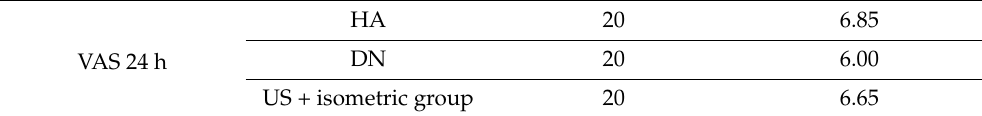
Table 3. VAS 24 h. Difference between HA group and DN group.